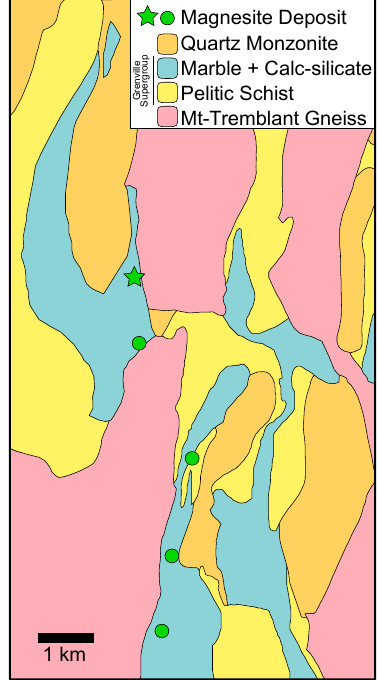
Figure 2. Morin terrane geology in the area of the Kilmar magnesite deposits, after [7] and references therein. Star is the location of the Dobbie mine.